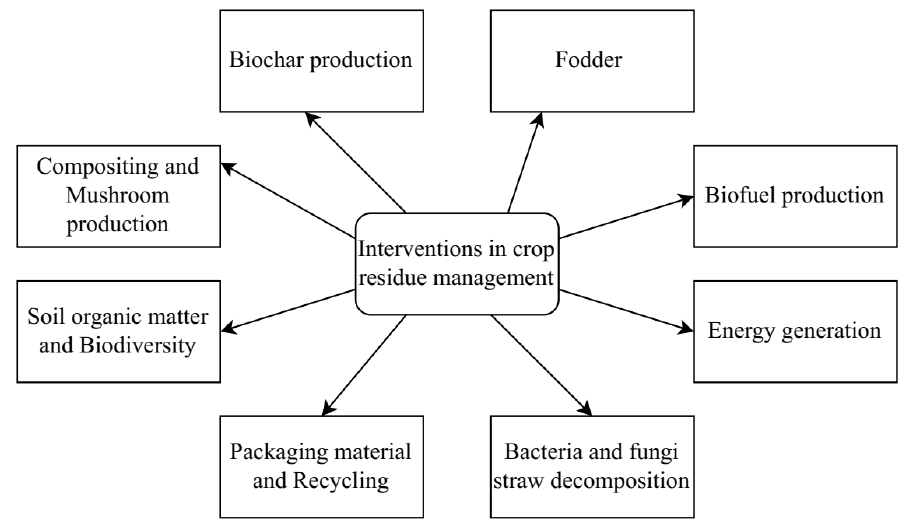
Figure 3. Potentially sustainable CRM solution for CRB.